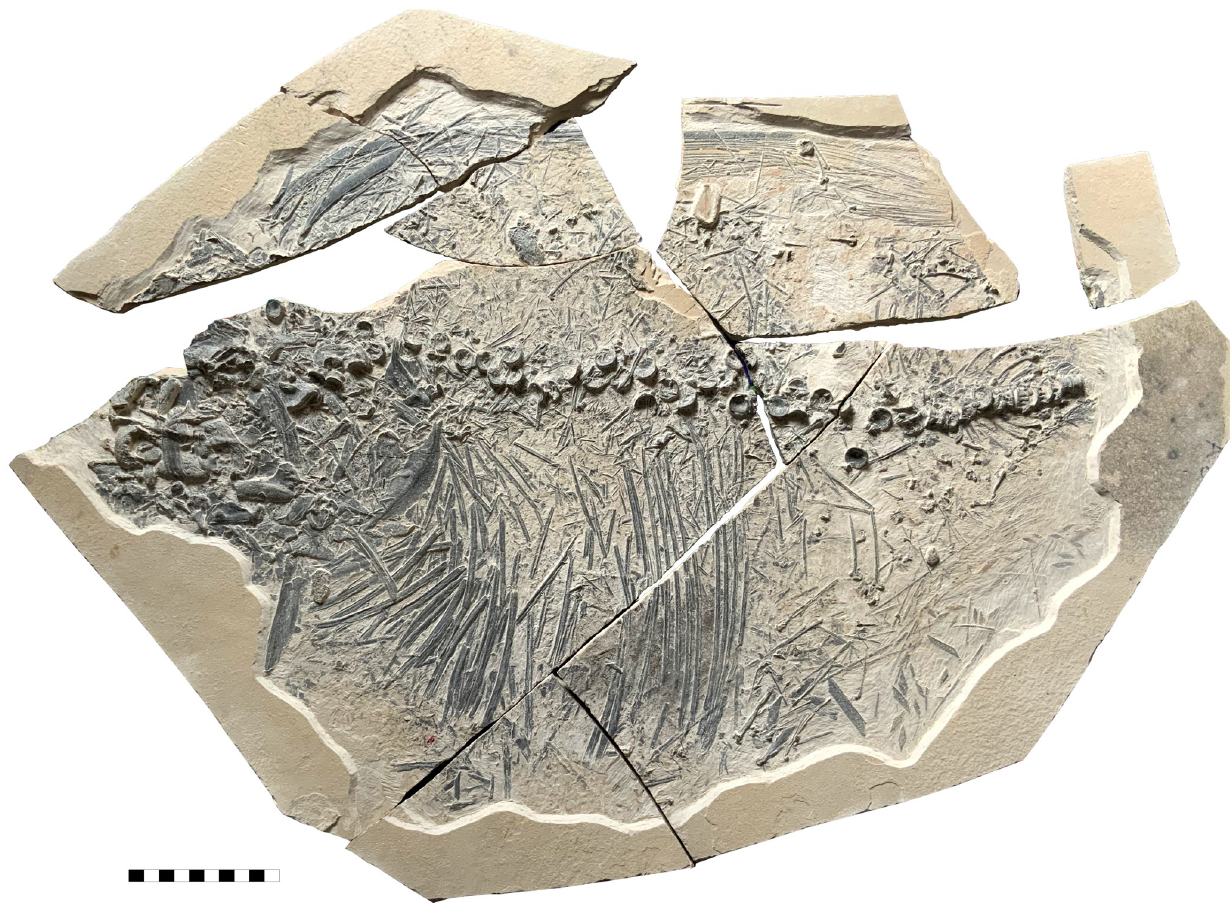
Fig 13. Disarticulated T . formosa (CPC-2833). The carcass disintegrated on the seafloor without bone dispersal caused by scavengers or currents. A phase of flotation is excluded. Scale 100 mm.